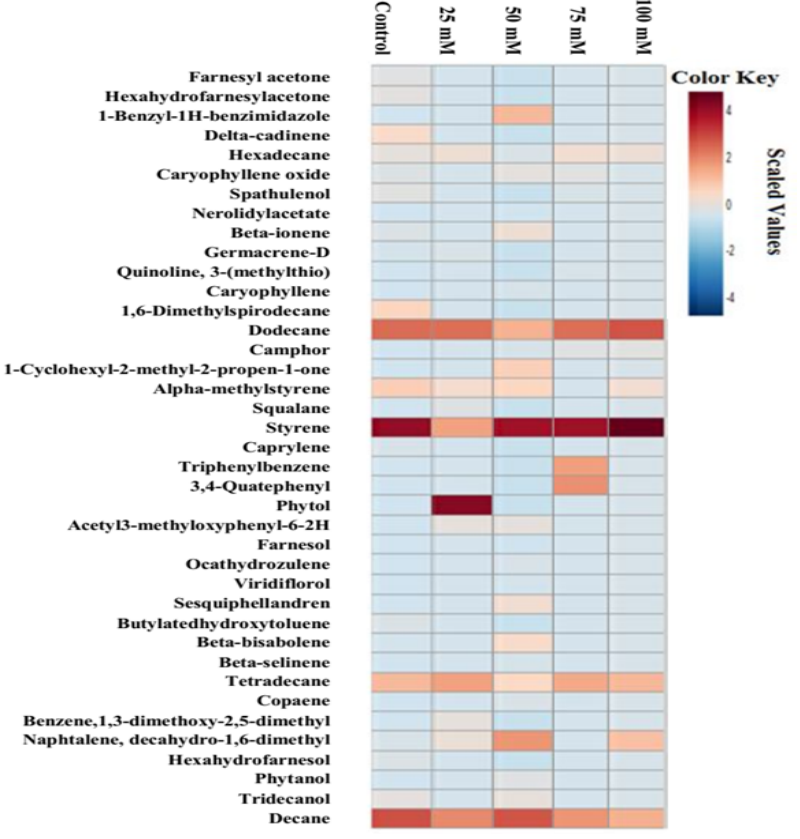
Figure 4 . The heat map of detected compounds under different NaCl concentrations . Figure 4. The heat map of detected compounds under different NaCl